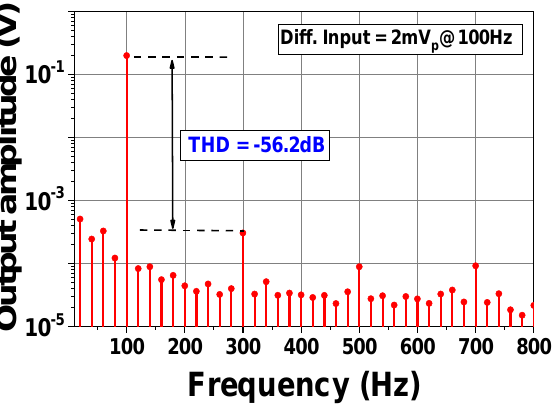
Figure 15. Linearity verification by applying FFT analysis of output voltage with 100 Hz input frequency. Table 2. Power breakdown.